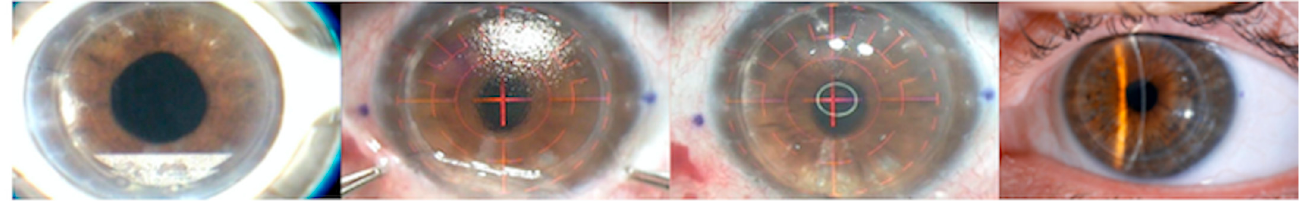
Figure 1. Sequence showing a Femto-LASIK surgery after DALK. The flap diameter was smaller than the graft diameter, and the excimer laser ablation was performed within the corneal graft limits without involving the graft-host